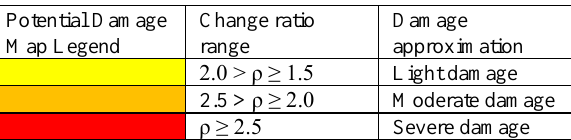
Table 1. Rapid damage map legend based on log ratio of complex coherence from stacked SAR